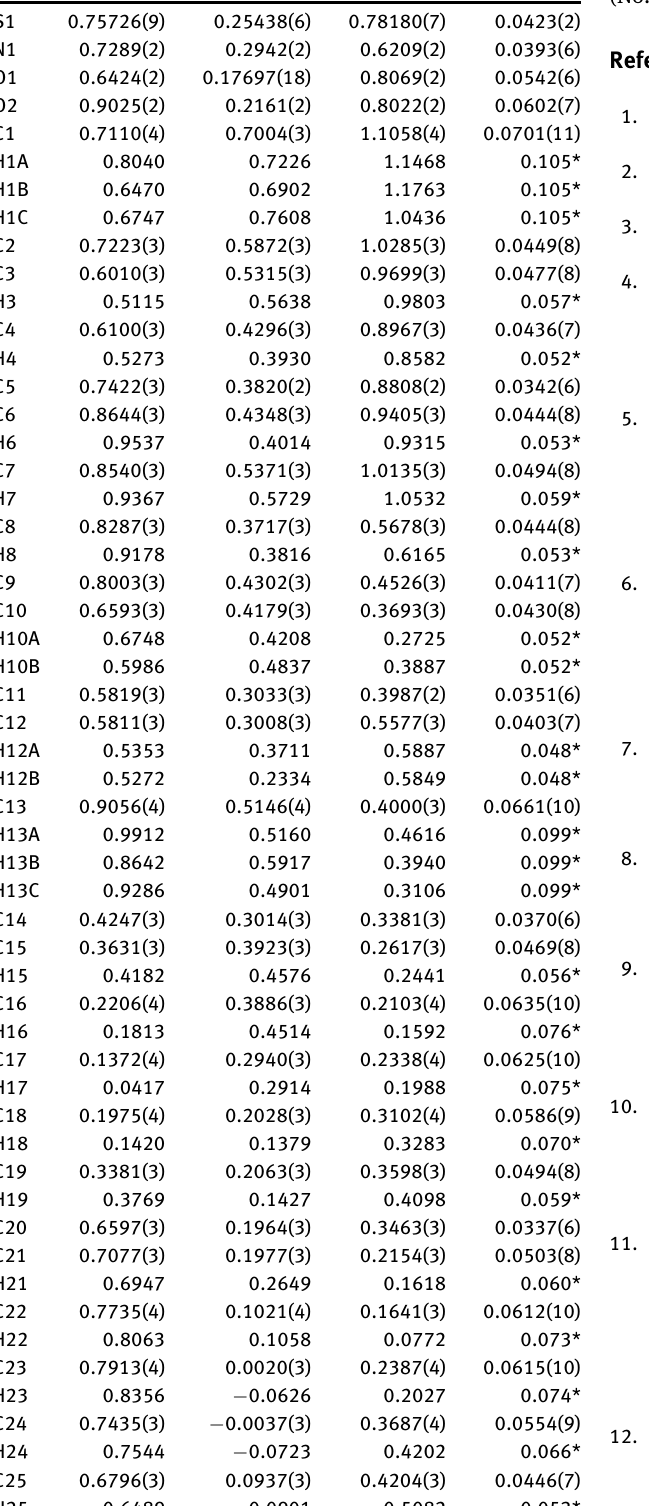
Table 2: Fractional atomic coordinates and isotropic or equivalent isotropic displacement parameters (Å 2